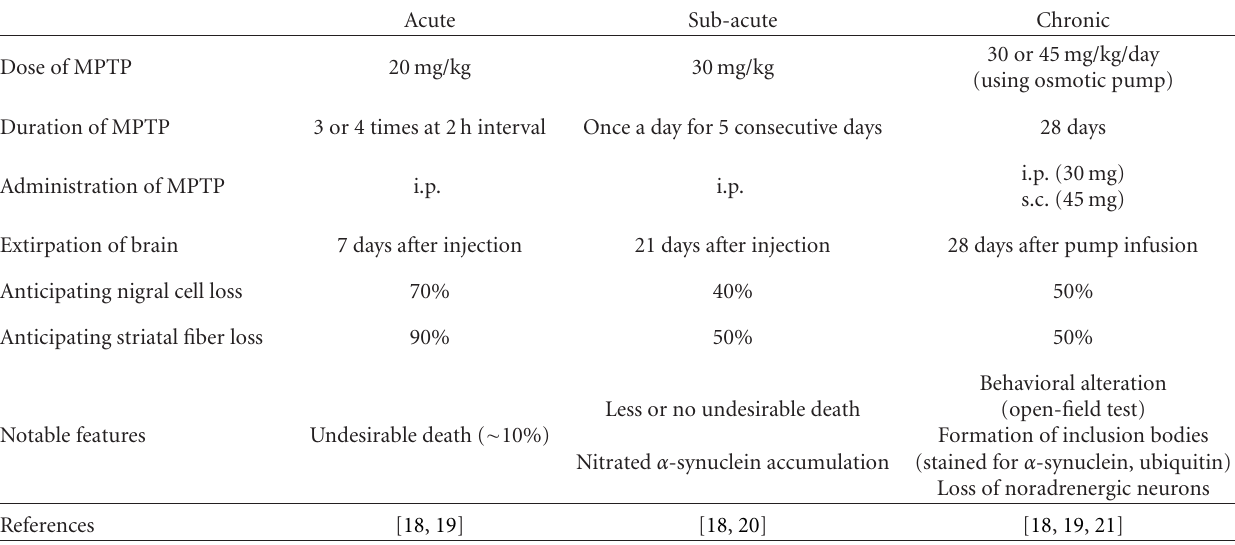
Table 1: Comparison of representative MPTP-PD models. Each written model is representative and reproducible examples of MPTP-PD model because many researchers modify their own protocols in creating MPTP-PD